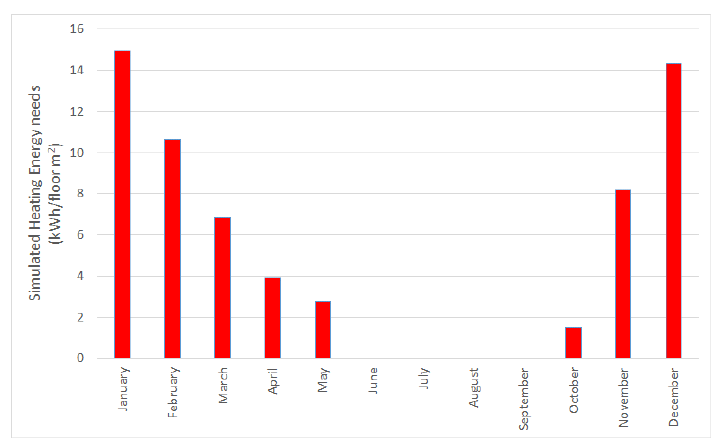
Figure 5. Simulated heating needs for the building under study.